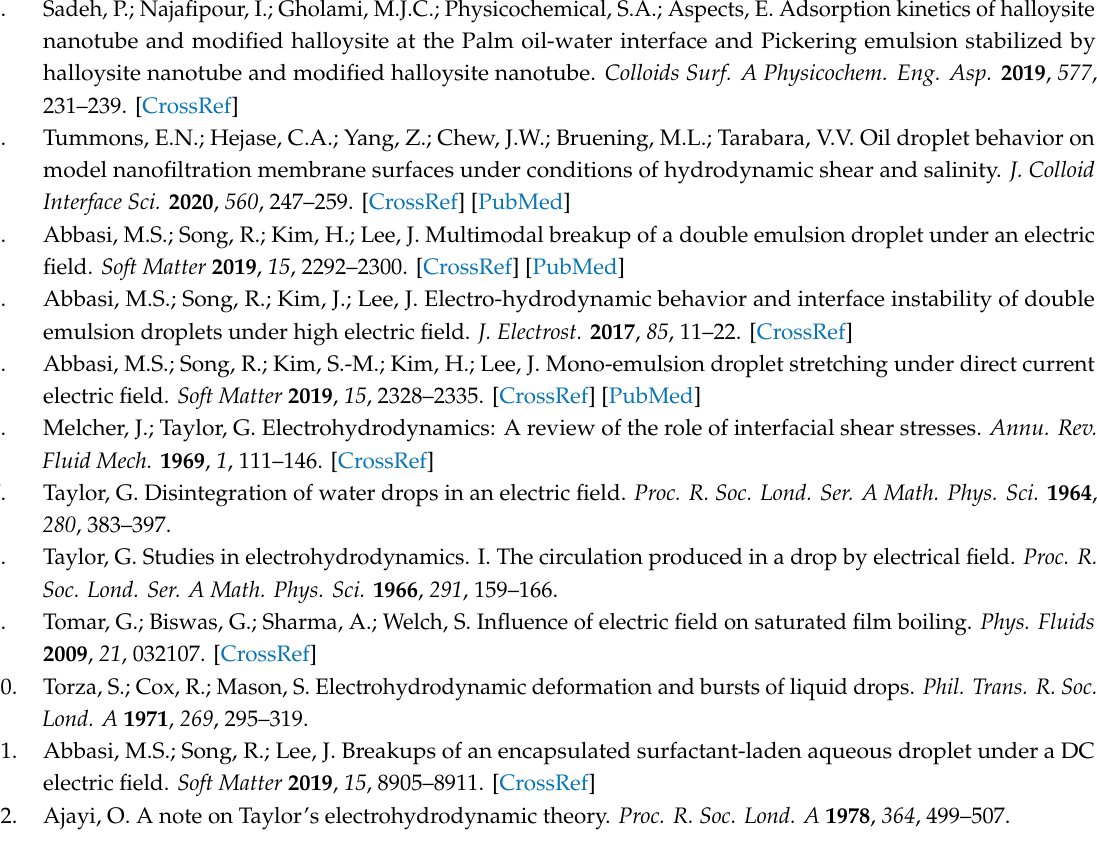
Figure S1: SEM images of the asphaltenes particles; (A) at a scale of 100 µ m, (B) at a scale of 10 µ m. Figure S2: The caps elongate over the drop interface and cover the entire interface as the electric field is removed. Table S1: Properties of the asphaltene particles used in experiments. Table S2: Systems for grid independence tests. Table S3: Grid independency and domain independency